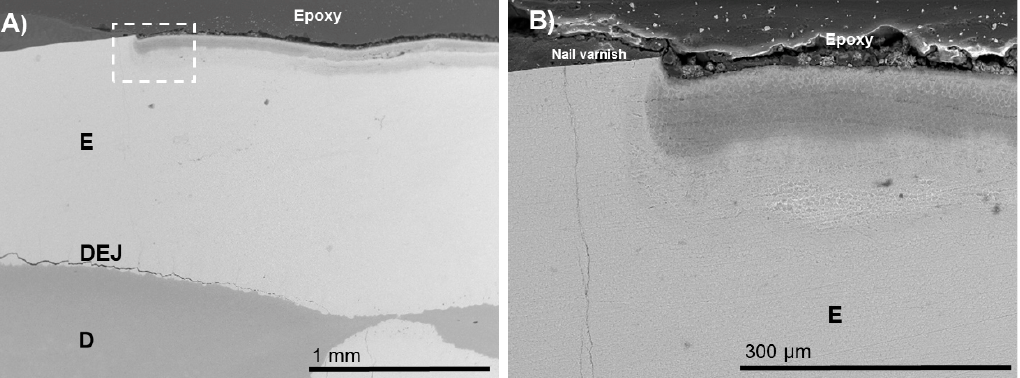
Figure 3. SEM images of the specimens in the bacteria-induced enamel demineralization followed by remineralization in PILP solution containing pASP as process-directing agent (BIED-REM pASP group). ( B ) High-magnification SEM image of ( A ) showing the area under the dotted outline rectangle. E: enamel; D: dentin; DEJ: dentin–enamel junction.